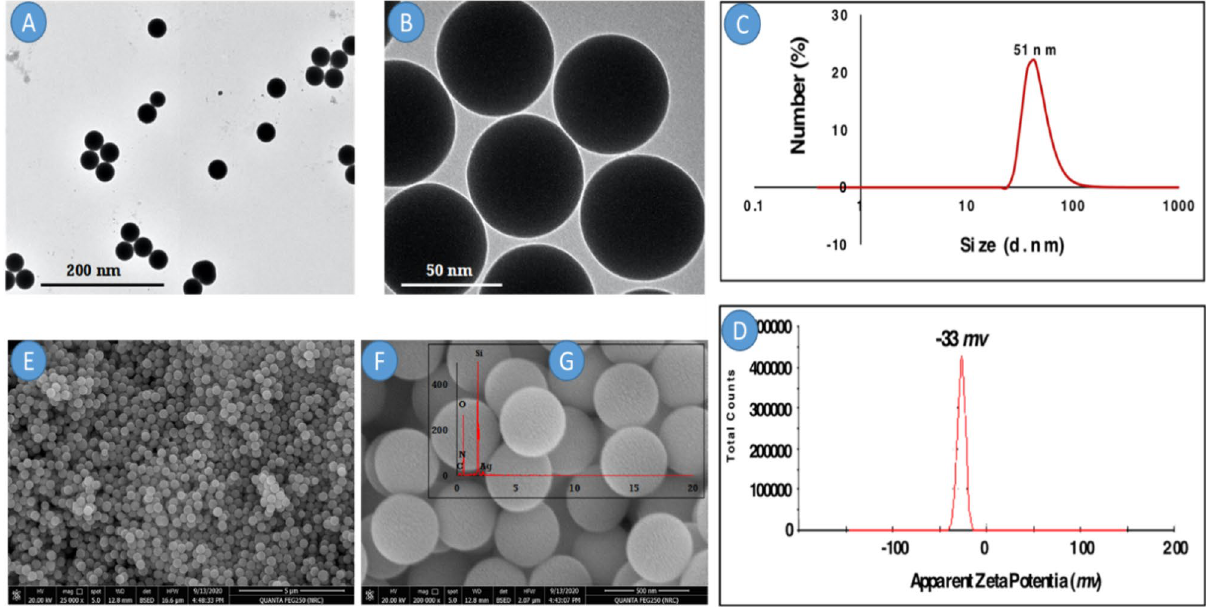
Figure 1. TEM of SiO 2 @AgNPs at ( A ) low magnification and ( B ) high magnification and ( C ) hydrodynamic size and ( D ) apparent zeta potential of SiO 2 @AgNPs and ( E ) SEM of SiO 2 @AgNPs at low magnification and ( F ) high magnification and ( G ) EDX of SiO 2